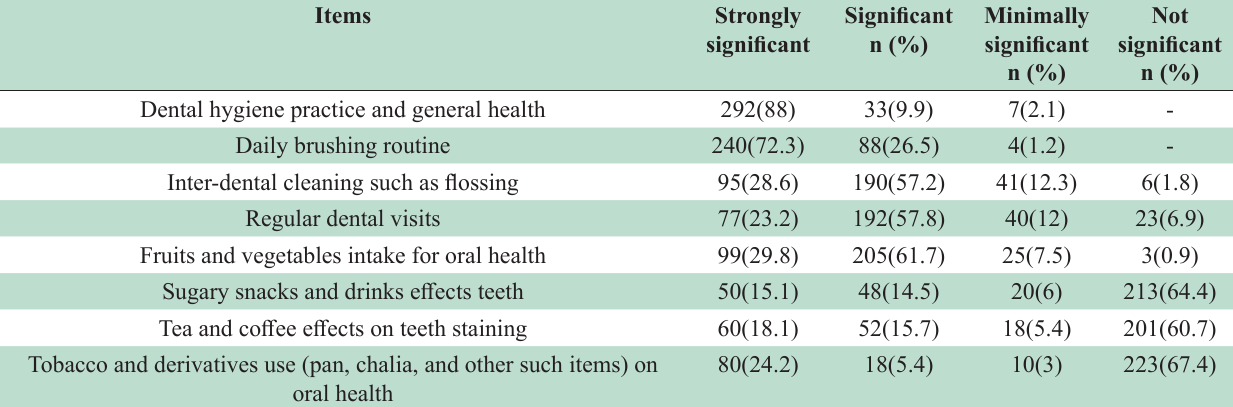
Table-III: Responses on Items regarding Oral Hygiene.